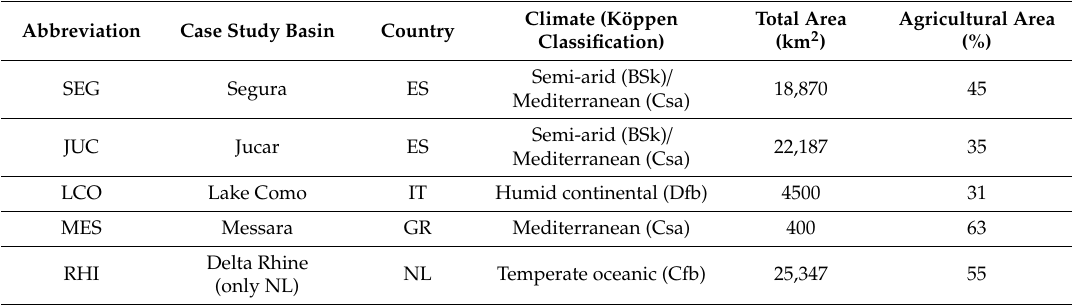
Table 2. Summary table of the case study